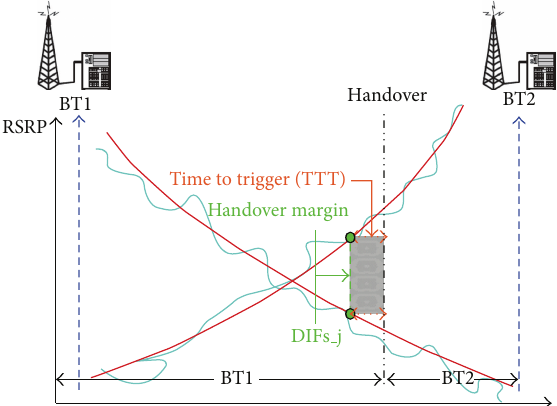
Figure 3: Handover Condition in LTE-A